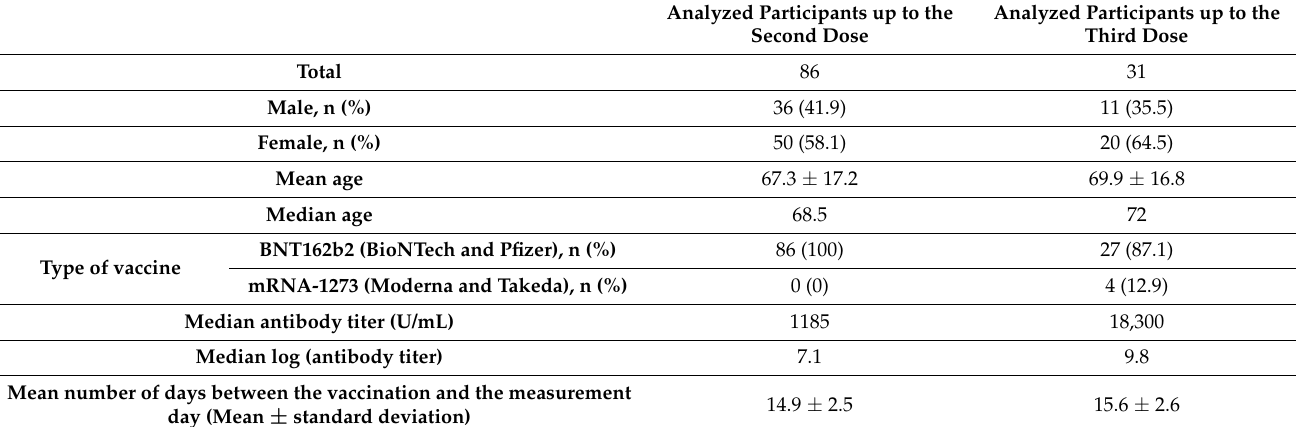
Figure 3. Histograms of the antibody titers ( A ) and log-transformed antibody titers ( B ) for 86 participants who had been vaccinated up to the second dose. Correlation between the days after the second dose and the log-transformed antibody titer ( C ). Correlation between the participants’ age and the log-transformed antibody titer ( D ). Table 2. Analyzed participants up to the second and third vaccine